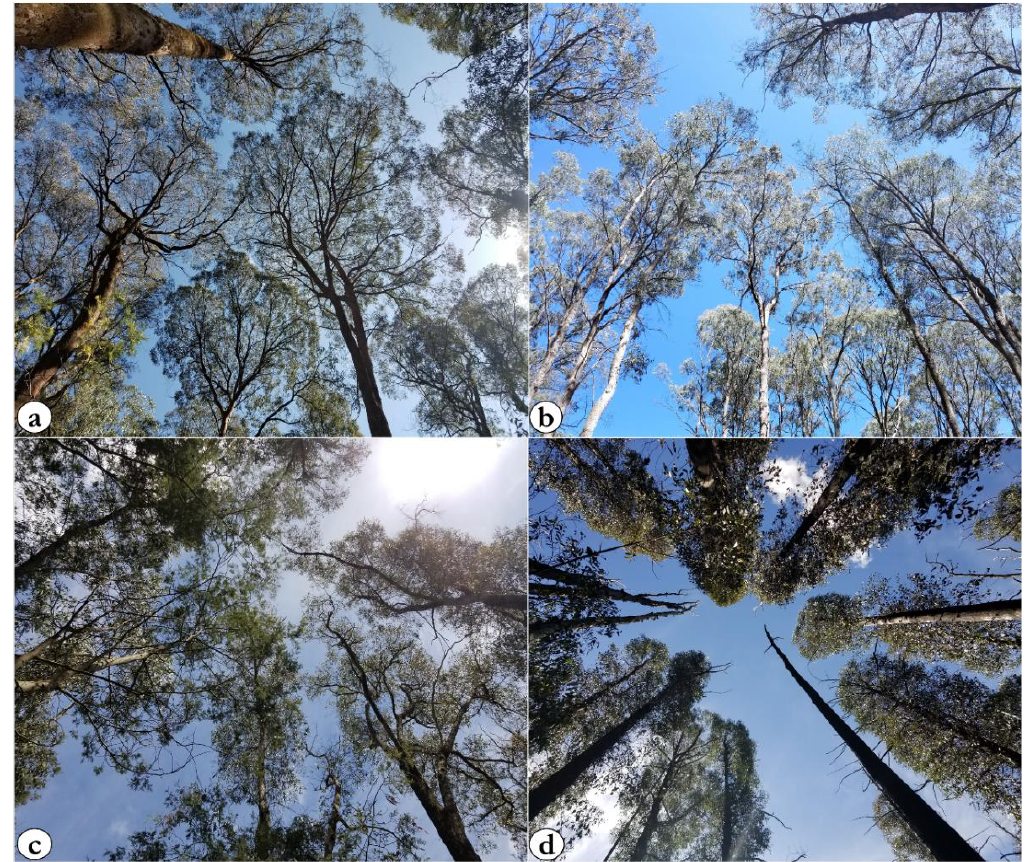
Figure 3. Fish-eye lens views of tree crowns representing each fire-severity type nearly nine years after the 2009 wildfire: ( a ) unburnt, ( b ) low, ( c ) moderate, ( d ) high fire